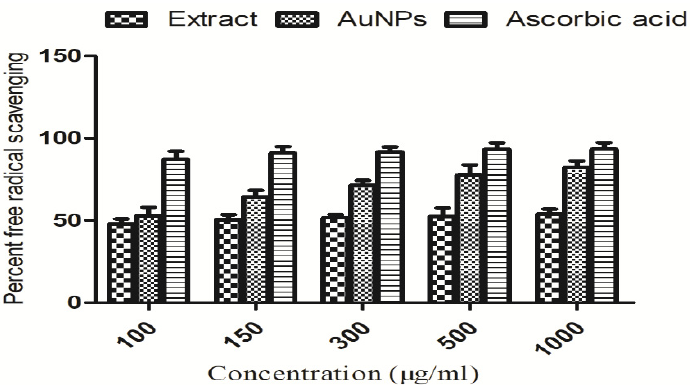
Figure 9. ABTS free radical scavenging capability of extract and its fabricated AuNPs.